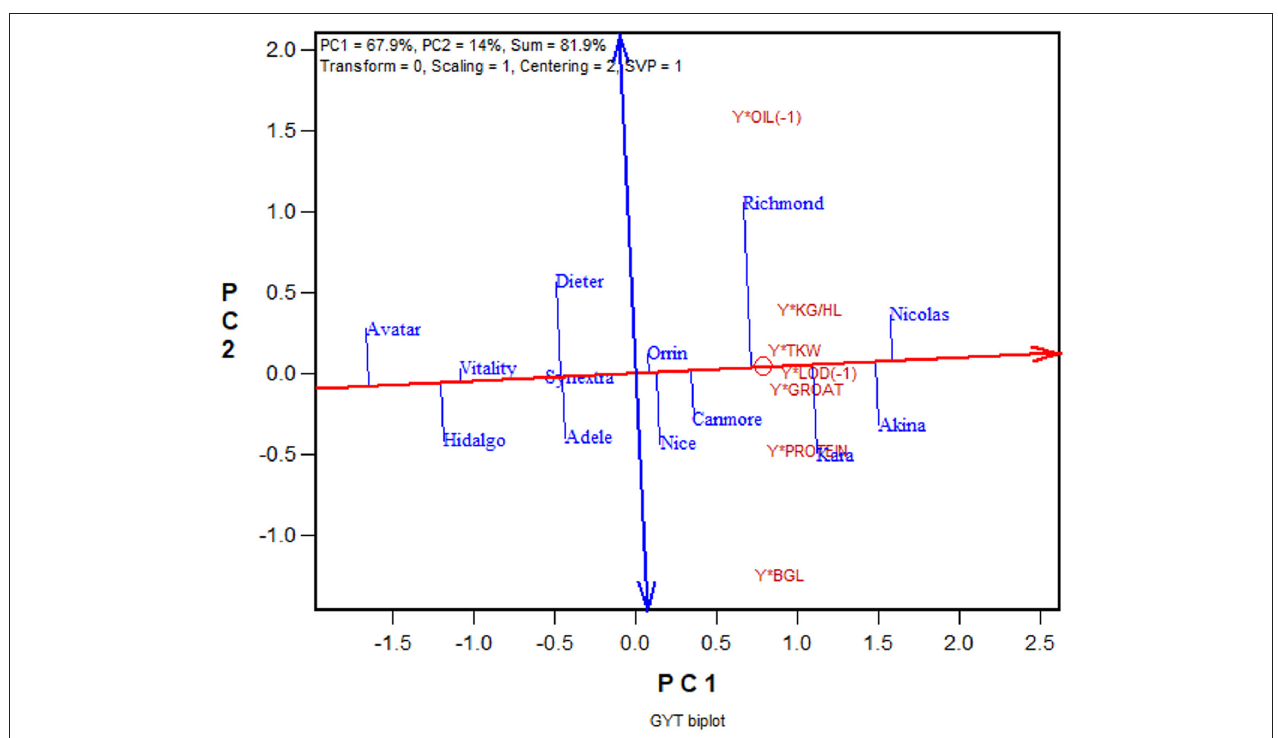
FIGURE 9 | GYT biplot to display the yield-trait combinations of 13 oat cultivars tested in the 2013–2019 Quebec provincial oat trials. The biplot was based on singular value decomposition of yield-trait combination standardized data (“Centering the arrow pointing to higher GYT index. The blue line with arrows on both ends indicate contrasting trait profiles of the genotypes. For example, it showed Richmond to be strong yield-oil combination but weak in yield- β -glucan combination, while Kara had the opposite trait profile to that of